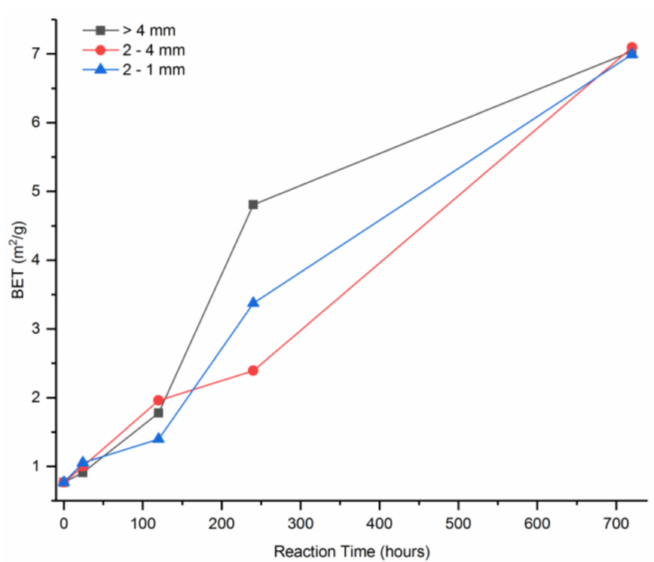
Figure 8. Specific surface evolution by specific surface area (BET) as a function of reaction time for MPC2 (modified from [5]).